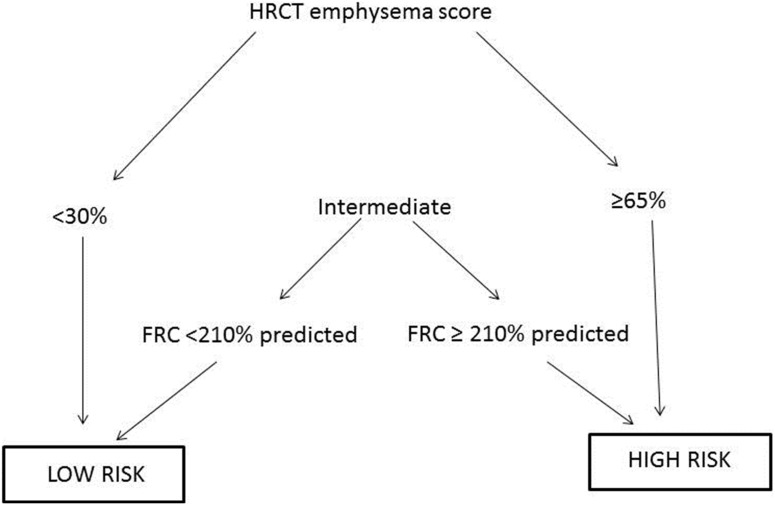
COPD prognostic staging in high and low risk, according to the ES-FRC composite index.